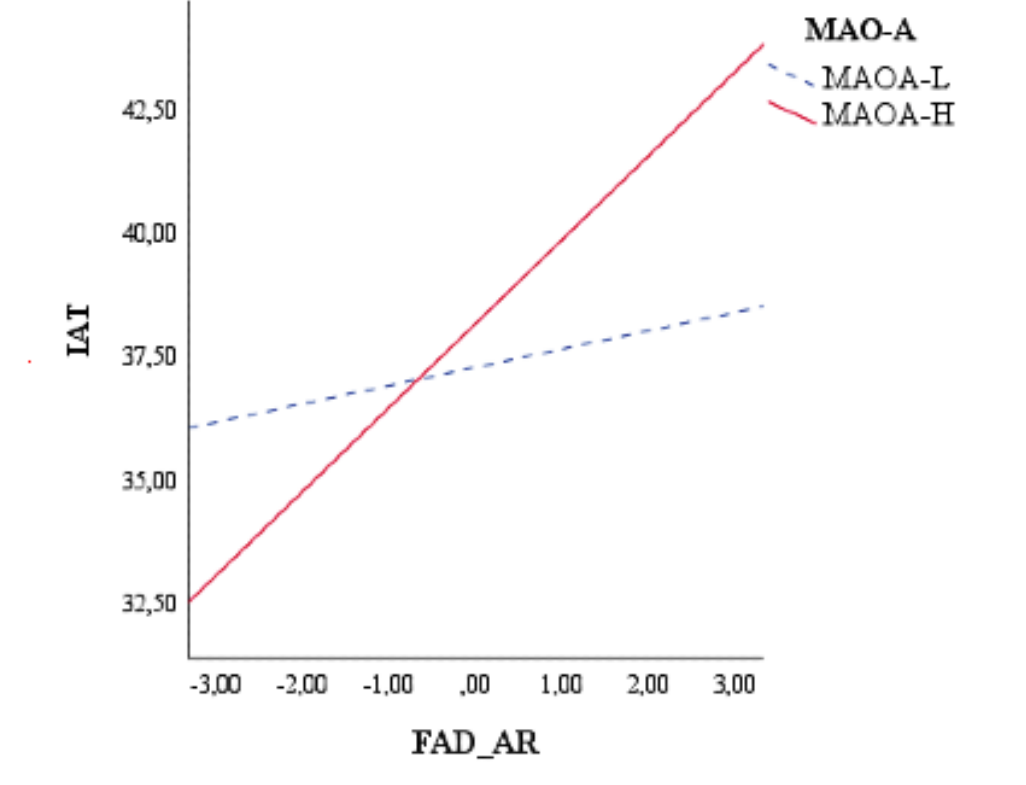
Figure 6. Moderation of the youth’s MAO-A genotype on the relationship between youth’s family functioning and IAT score. FAD_AR: Family Assessment Device Affective Responsiveness; IAT: internet addiction test; MAO-A: monoamine oxidase A; MAOA-H: MAO-A high-activity variant; MAOA-L: MAO-A low-activity